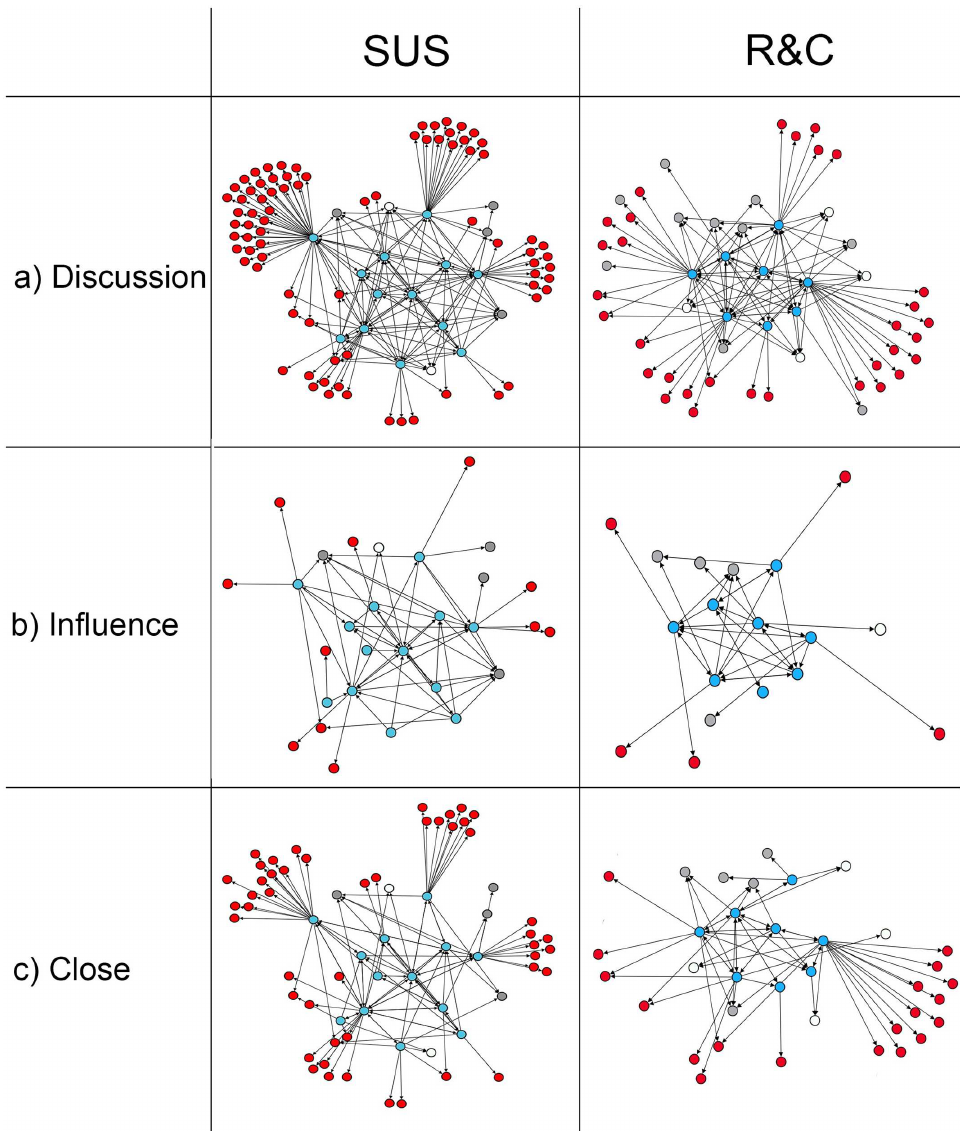
Fig 1. Diagrams of the Shape Up Somerville (SUS) and Romp & Chomp (R&C) steering committee networks for a) discussion, b) influential and c) close relationships during the community-based childhood obesity prevention interventions. Key: Blue = respondents, White = non-respondent consenting SC members, Grey = non-consenting members, and Red = other nominated contacts external to the SC.